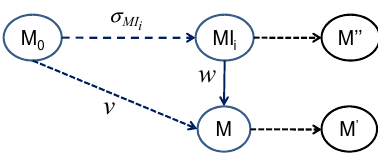
Figure 2. Prefix of a given sequence.